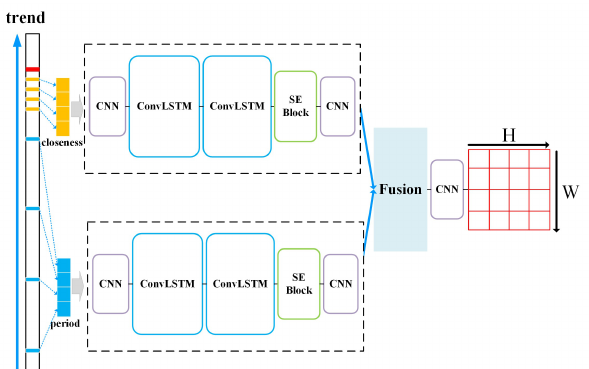
Figure 1 . The framework of